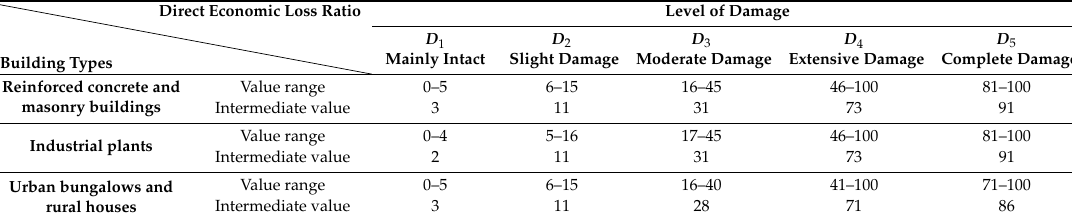
Table 4. The value ranges for direct economic loss ratios of di ff erent types (unit: %) [65].